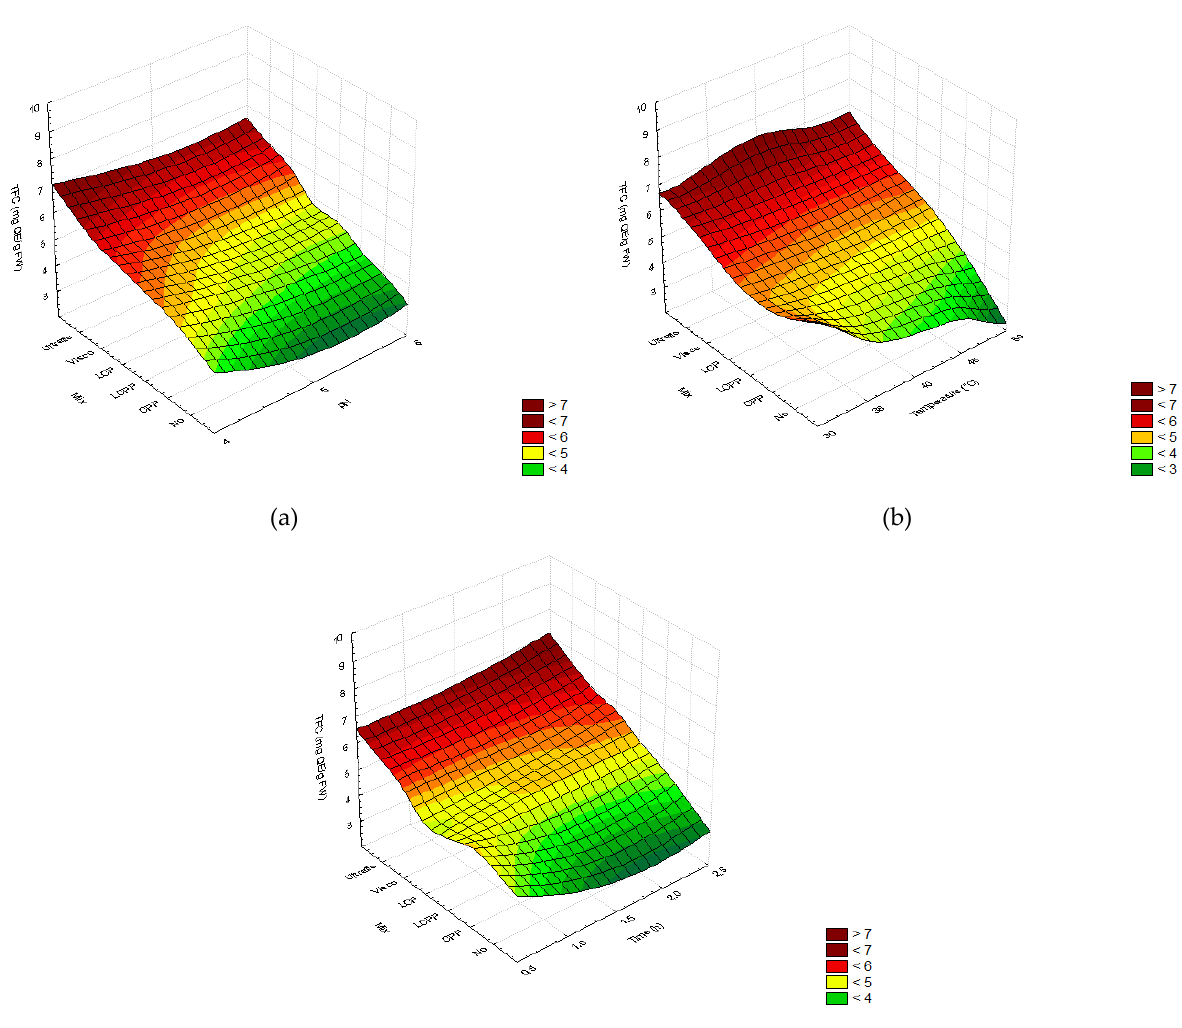
Figure 5. The total phenolic content (mg GAE/g FW) in the ethanolic extracts plotted as a function of the different enzy- matic cocktails and; ( a ) pH (4 – 6), ( b ) temperature (30 – 50 °C), and ( c ) time (0.5 – 2.5 h). In order; two commercial cocktails: Ultraflo© (Ultraflo) and Viscozyme© (Visco); three formulated cocktails with laccase, cellulase, and pectinase in propor- tion 1:1:1 (LCP), 1:1:2 (LCPP), and 0:1:2 (CPP); and the control without enzymes added (No). The color scale indicates the significance of the analysis of variance for the Taguchi method (n = 3, p > 0.05).